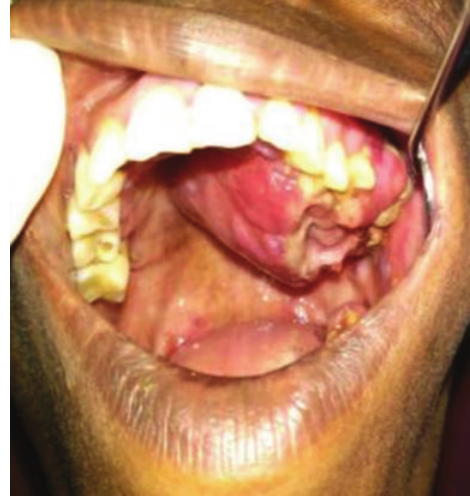
Figure 3: Heterogenous, well-defined, intensely enhancing lesion measuring 3 × 4.1 × 4.3 cm (cc × ap × trans) seen involving left side of buccal mucosa and the hard palate with displacement of lingual septum to right.